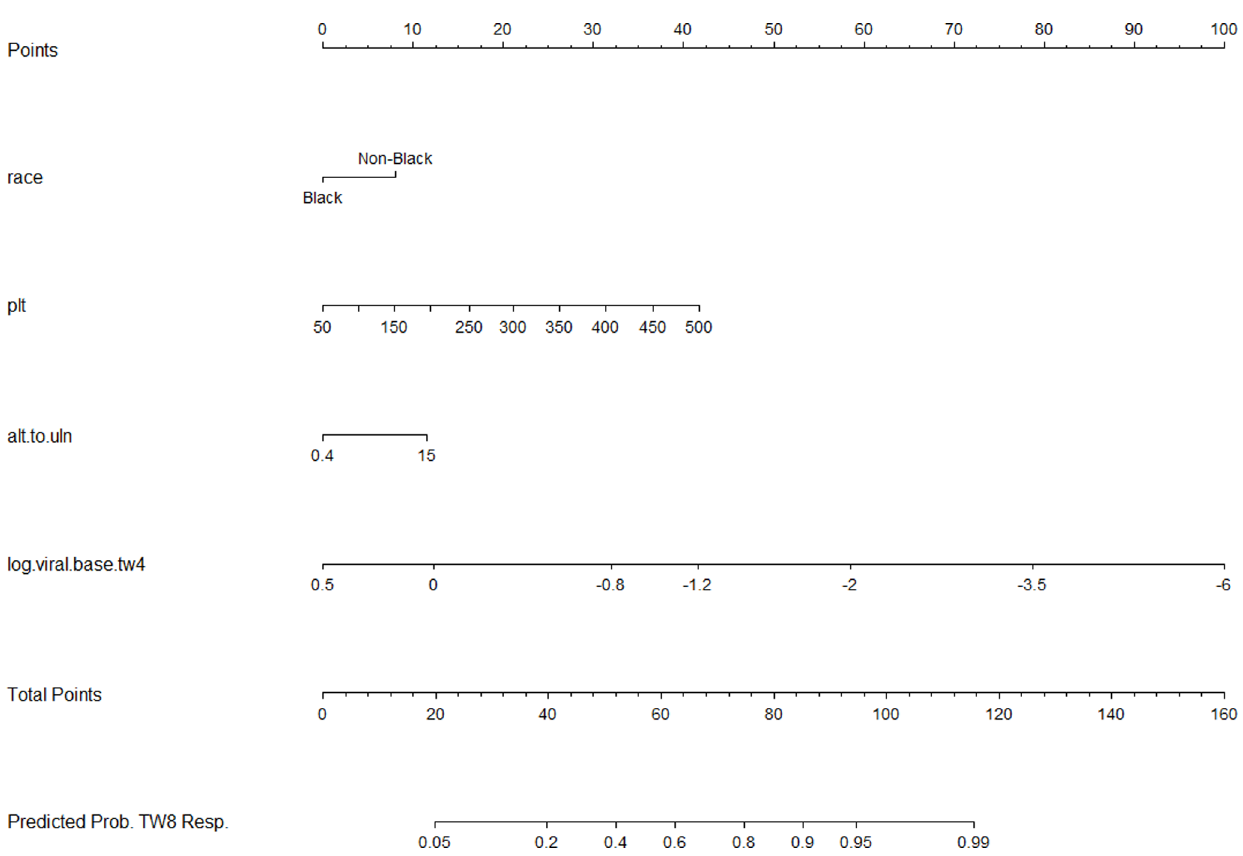
Figure 1. Nomogram for predicting TW8 response in null responders, partial responders, relapsers and previously untreated patients treated with Boceprevir + PR. Instructions: This nomogram is a visual representation of the regression model built to predict TW8 response to boceprevir. It can be used to calculate a patient’s predicted probability of becoming undetectable at TW8 if they have initiated boceprevir treatment. To use it, first circle the patients TW4 HCV-RNA on the TW4 HCV-RNA scale. By drawing a straight line upwards to the points scale. This represents the number of points for that patient based upon their TW4 HCV-RNA level. For example, if they have a value of # 1500, the point score would be 100. Repeat this procedure for each of the variables presented in the nomogram. Once all point scores are determined, sum the total points and circle that value on the Total Points scale after the last variable. Draw a straight line downward from the Total Points scale to determine an individuals predicted probability of a TW8 response.